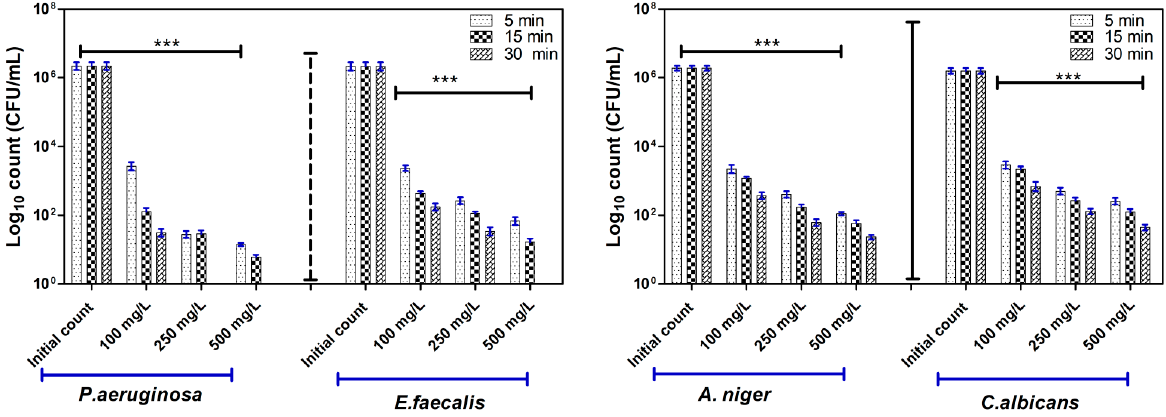
Figure 10. Colony-forming unit and MIC values of AgNPs-2@NFs against human-associated path- ogens including P. aeruginosa, E. faecalis, C. albicans , and A. niger . The remaining viable cell popula- tions at various time intervals of 5, 15, and 30 min are shown. Two-way analysis of variance